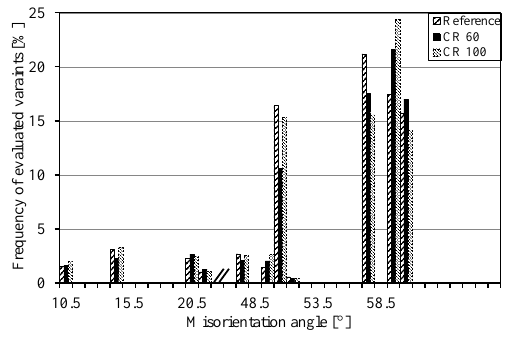
Figure 7. The frequency of the evaluated variants in each sample.